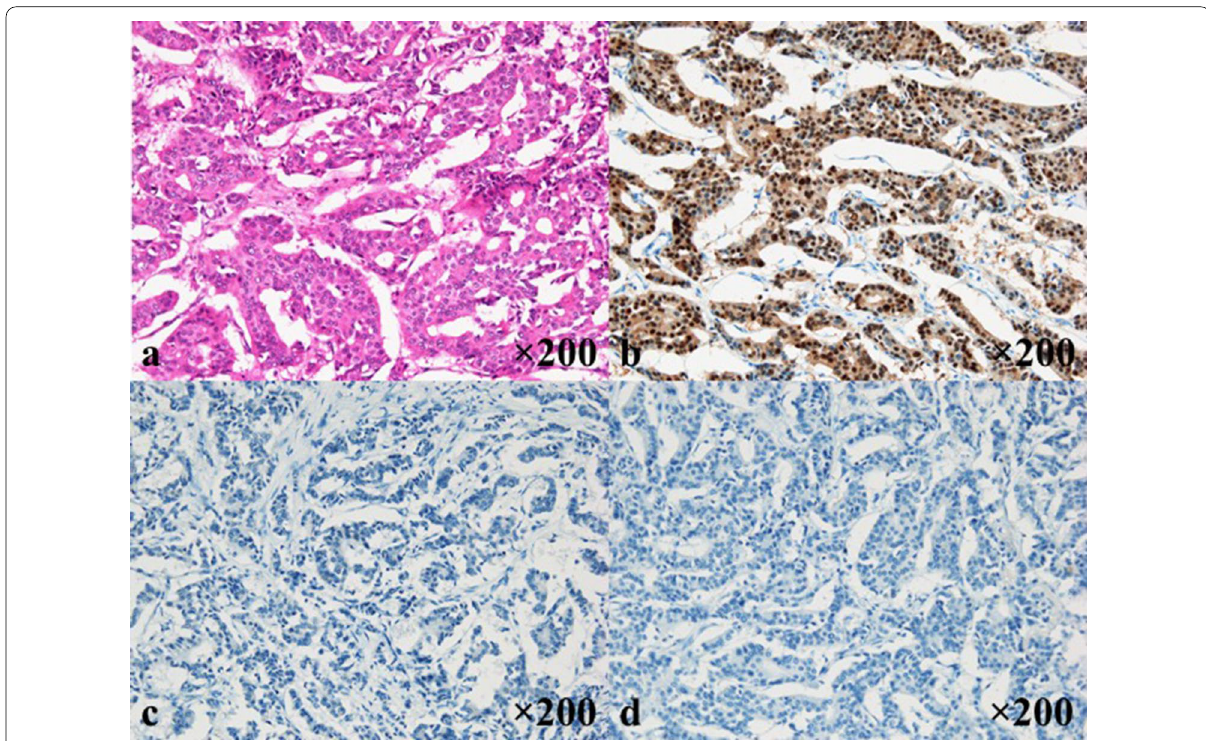
Fig. 1 Pathological findings of the primary breast cancer. Pathological sections were cut and stained at the time of relapse, due to no information available from the original episode. a H&E staining (